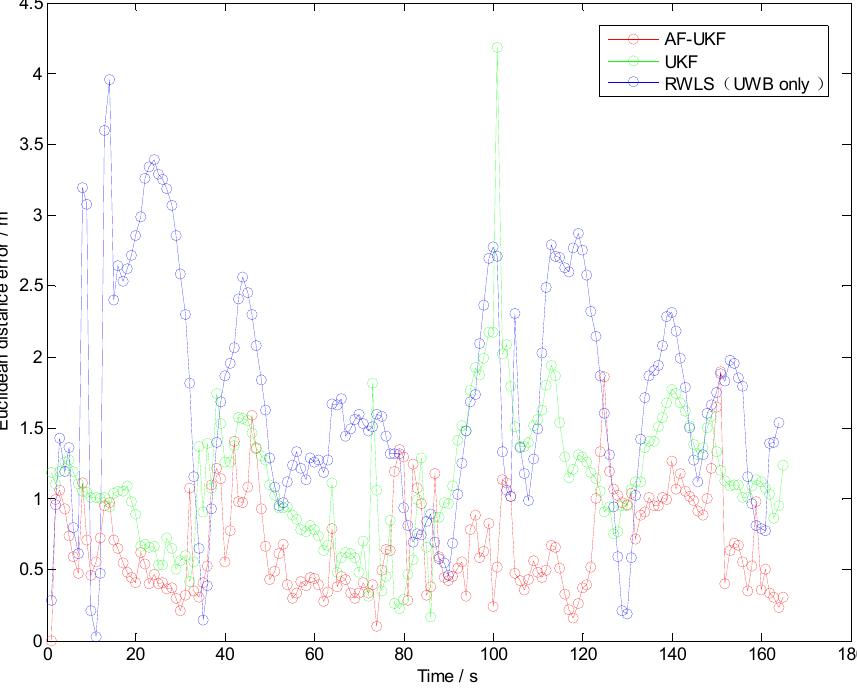
Figure 12. Positioning results in Trajectory V (Comprehensive Test).